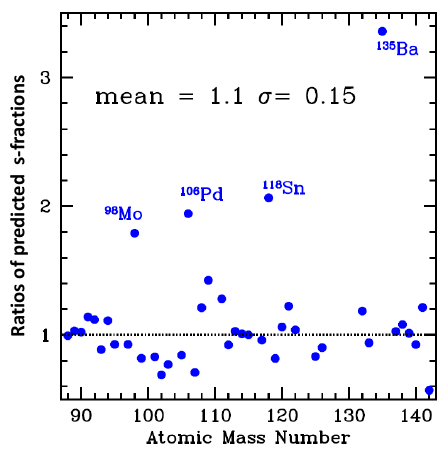
Figure 3. Discrepancies between the expectations of solar abundance fractions from slow neutron captures derived from the models discussed here and the s -residuals computed from r -process models according to relation